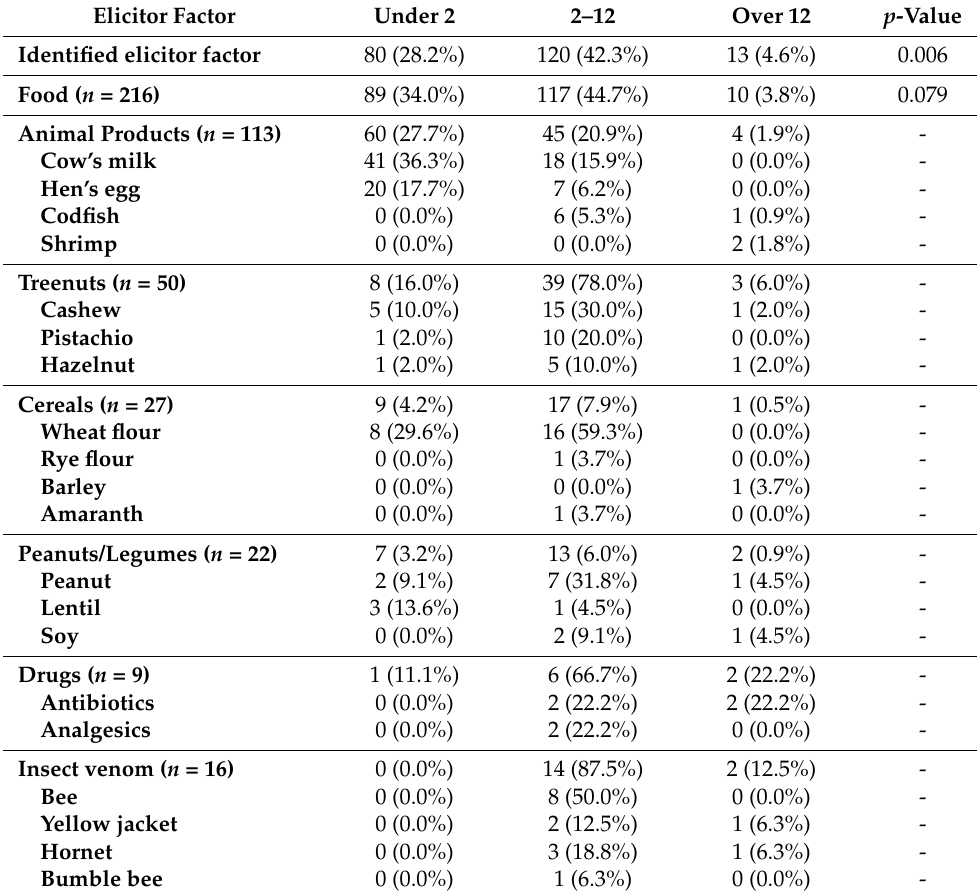
Table 2. Implicated